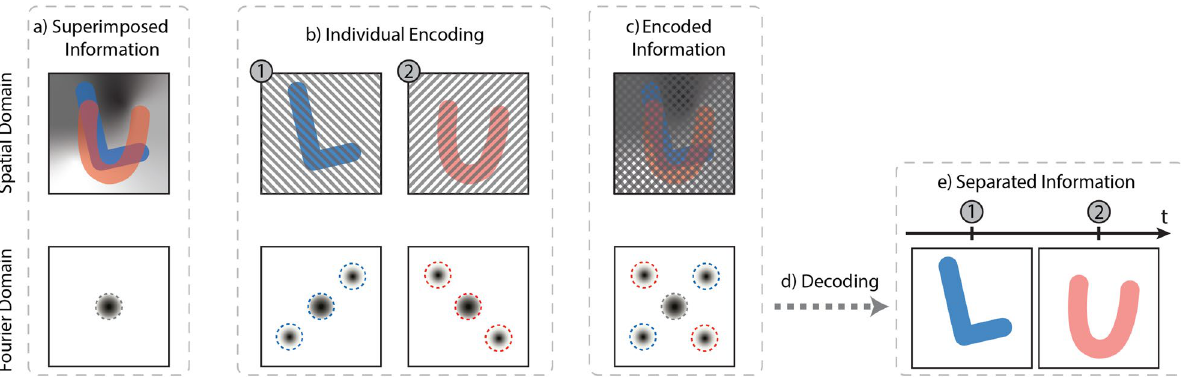
Figure 1. The working principle of FRAME. With no applied spatial modulation, all the image information (the L and U along with an independent background light field) is superimposed and centered in the Fourier domain ( a ). Upon application of unique spatial modulations, the individual image information is shifted into empty areas of the Fourier domain ( b ), allowing for the separation of the timestamped snapshots taken within one exposure ( c ). Applying a spatial lock-in algorithm followed by a low pass filter ( d ), the individual images can then be extracted, with a suppressed background light field ( e